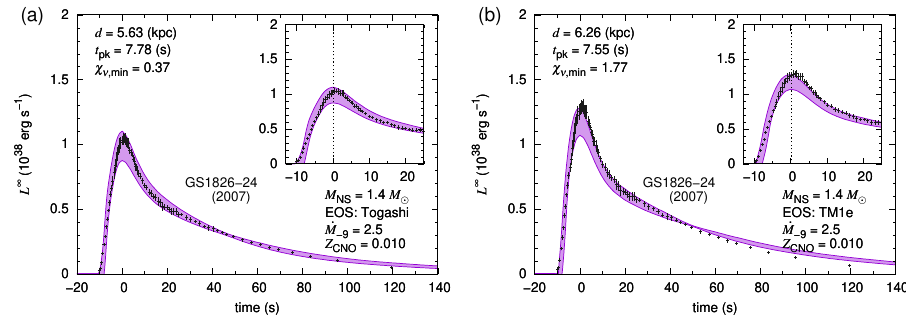
Figure 3. Comparison of calculated averaged burst light curves with observed ones of GS 1826–24 in 2007, assuming ˙ M − 9 = 2 . 5 , Z CNO = 0 . 01 and M NS = 1 . 4 M (cid:12) : (a) Togashi , (b) TM1e. We set t = 0 s at the peak time of light curves and plot within 1 σ regions of many burst light curves. The distance including burst anisotropy d , the time after the peak t pk , and the minimum χ 2 value χ ν, min are also